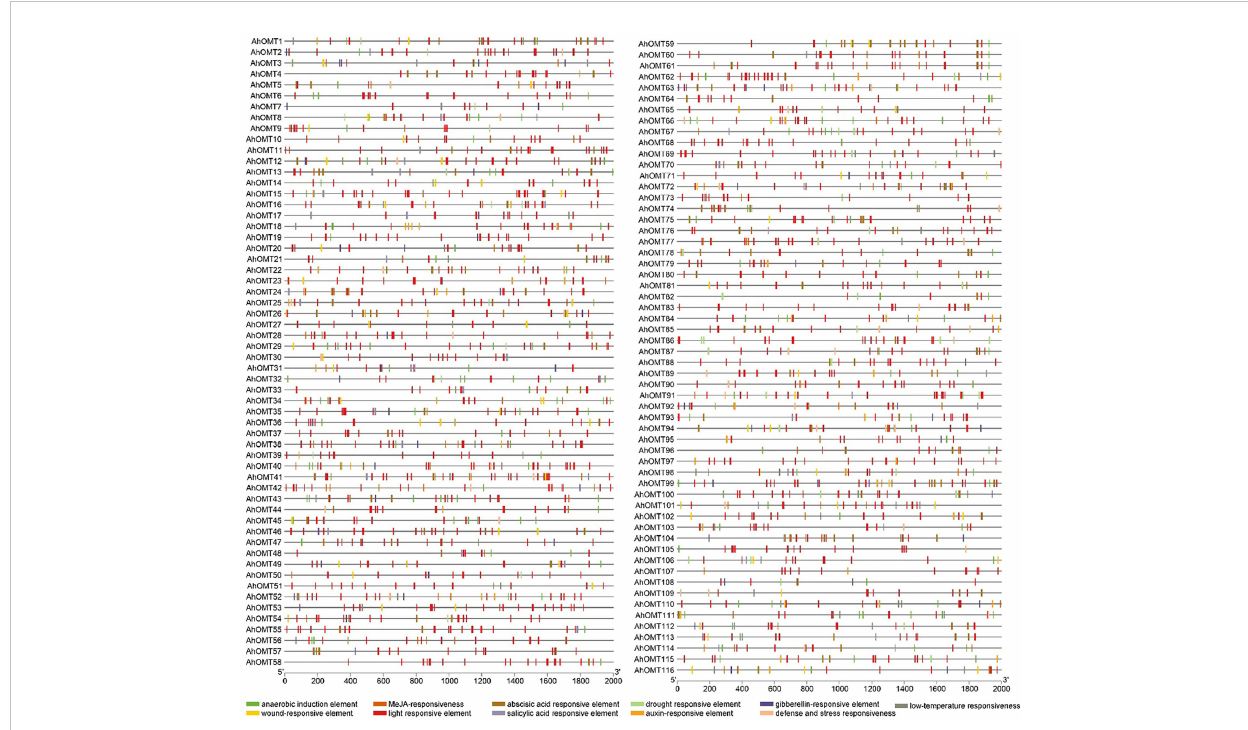
FIGURE 5 Cis -regulatory elements of AhOMT promoters. Cis -elements analysis revealed important elements responsive to light, hormones, growth and development, and stress